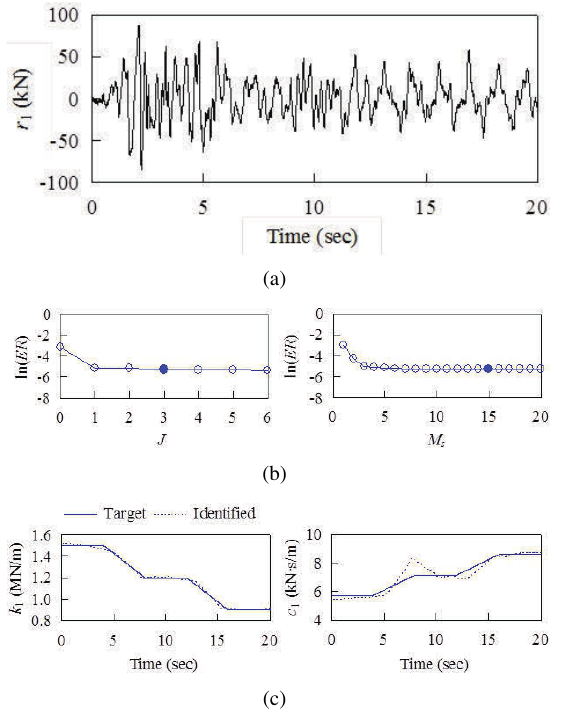
Figure 6. (a) Measured 1 st story restoring force; (b) resolu- tion level and significant term selection; and (c) identified 1 st story